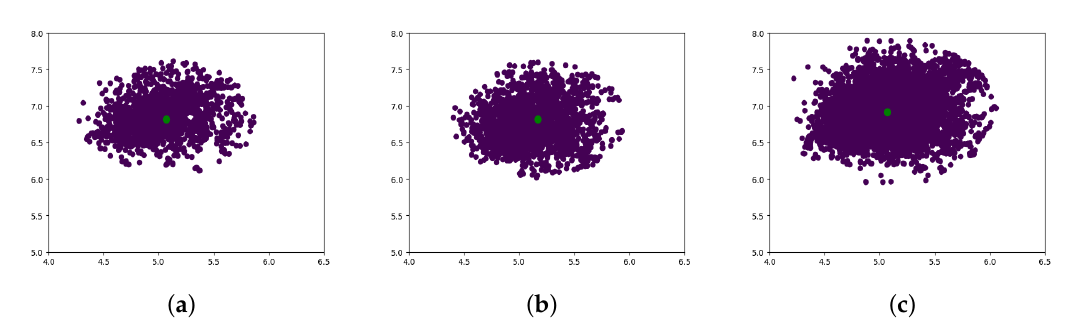
Figure 10. Examples of the error cluster center distribution of each combination. ( a ) The cluster centers distribution of 3416 groups of the combinations of 23 images; ( b ) The cluster centers distribution of 5468 groups of the combinations of 38 images; and ( c ) The cluster centers distribution of 8437 groups of the combinations of 54 images.The purple points are the cluster centers of each combination and the green points are the newly calculated cluster centers in all purple points.